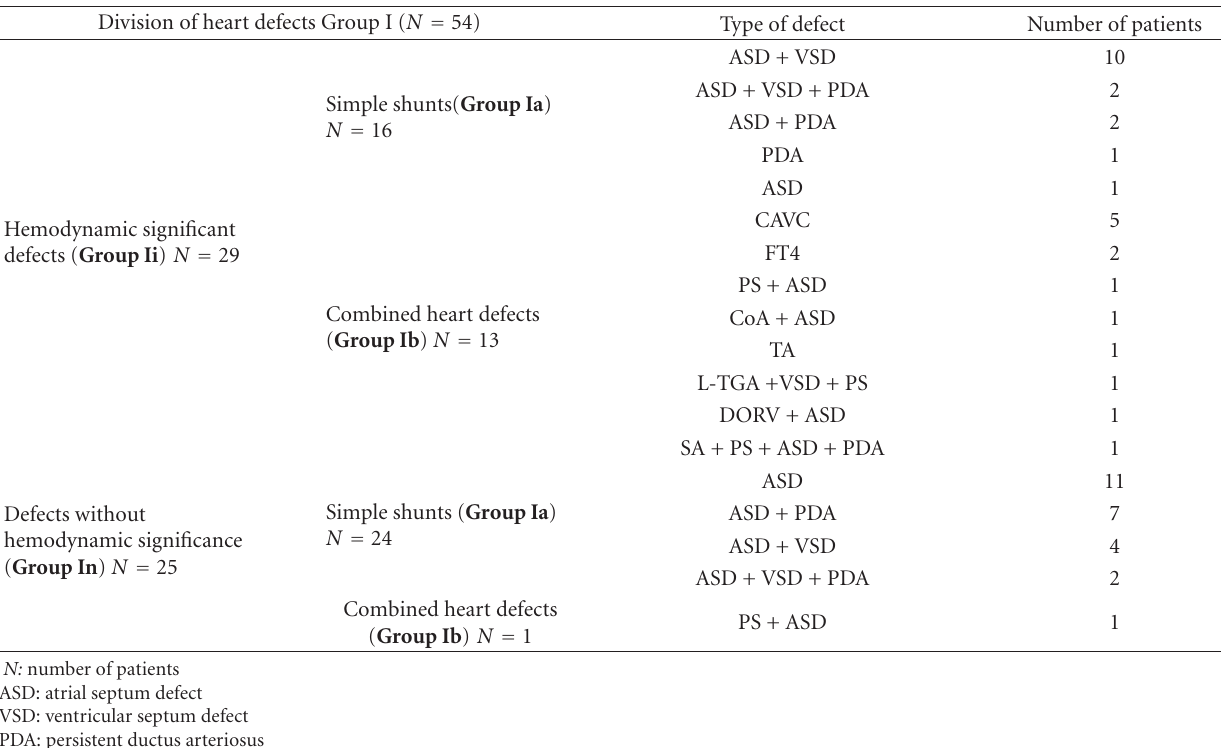
Table 1: Characteristic of heart defects in group I patients.